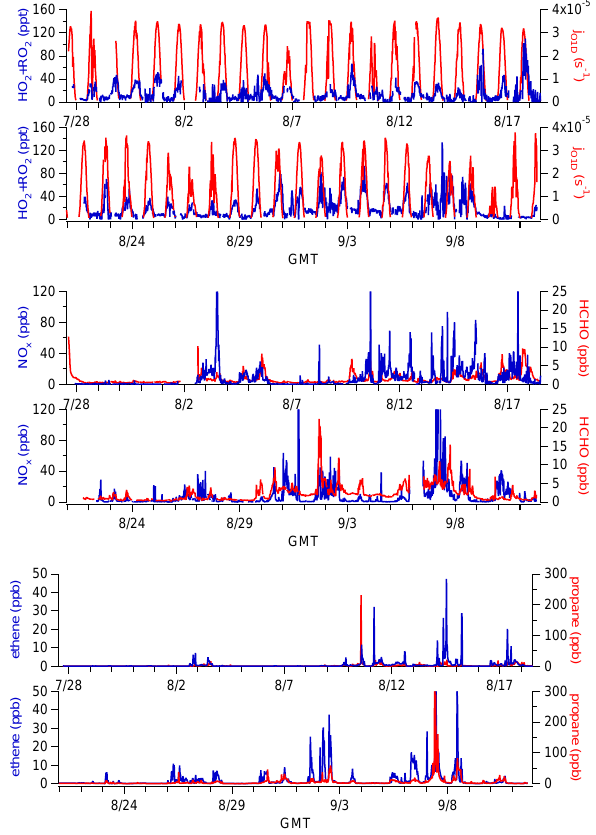
Fig. 4. Measurements of HO 2 + ΣRO 2 , j ( O 1 D ), NO x , HCHO , ethene and propane during the R/V Brown cruise. 33